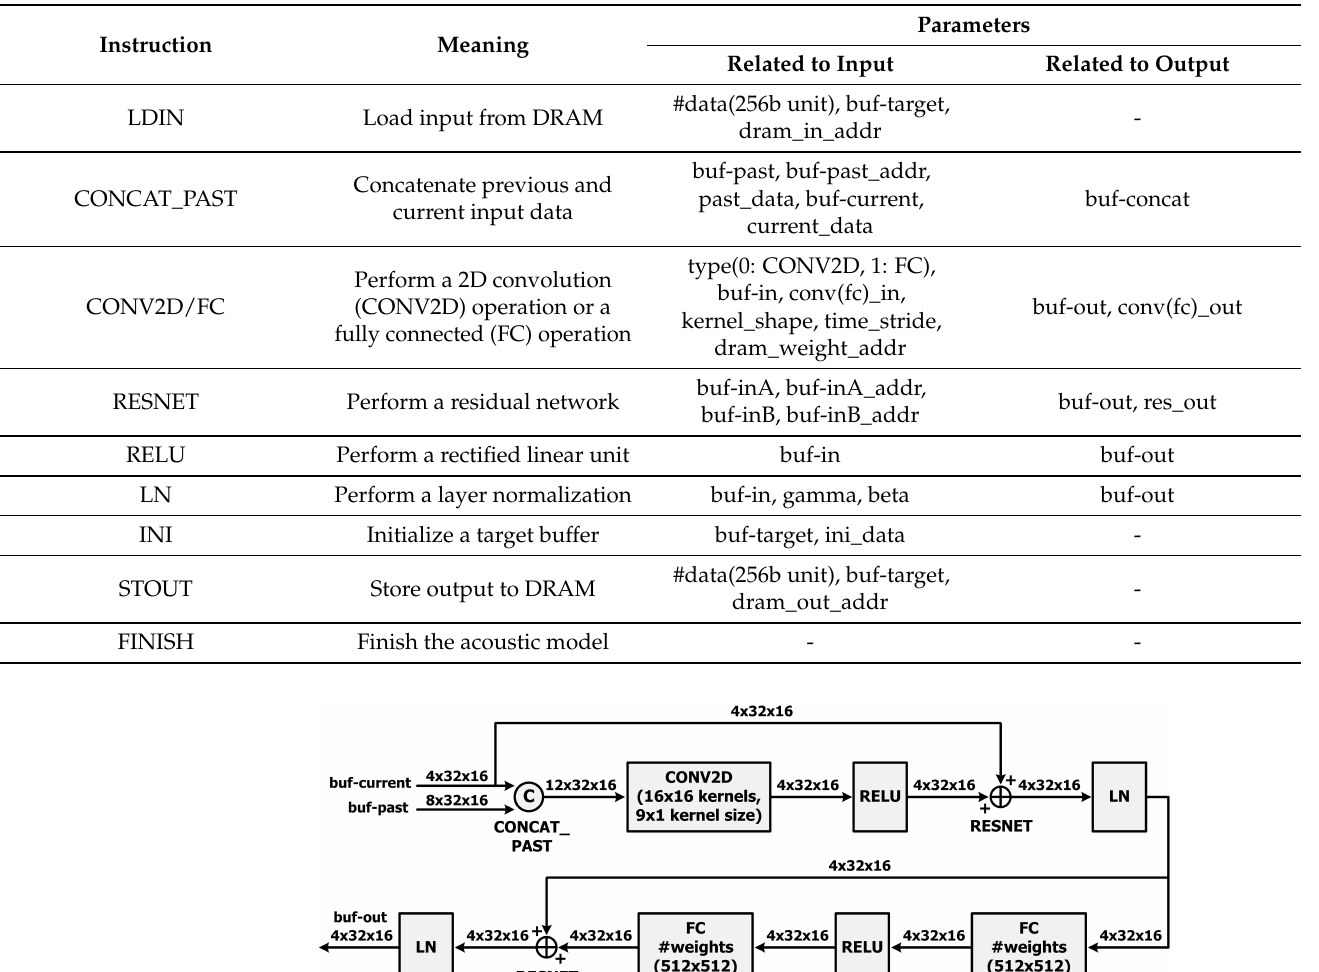
Table 5. Instruction set for hardware AM.